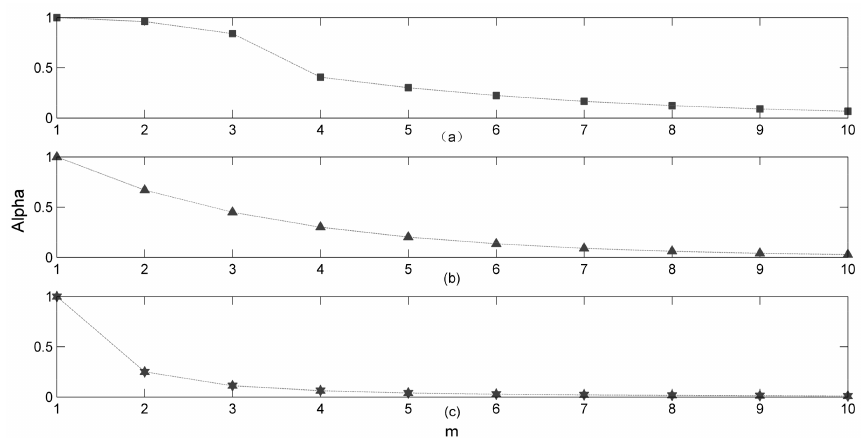
Figure 1. Learning curves under different functions (the values of parameters in ( a ) are: a = 0.04, b = 0, C o = 0.3, m 0 = 3; the value of parameter in ( b ) is: C o = 0.4; the values of parameters in ( c ) are: C o = 0.2, k =